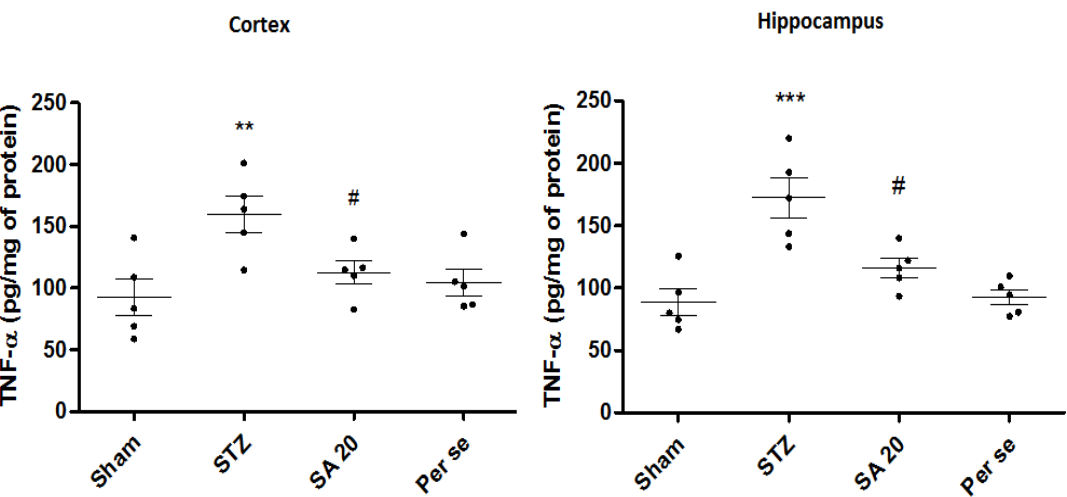
Figure 7. Effect of sinapic acid on TNF-α level in the cortex and hippocampus. Data are presented as mean ± SEM, ( n = 5). * as compared to the sham group, # as STZ compared to the STZ group. ** p < 0.01, *** p < 0.001, # p < 0.05. STZ—Streptozotocin, SA—Sinapic acid.